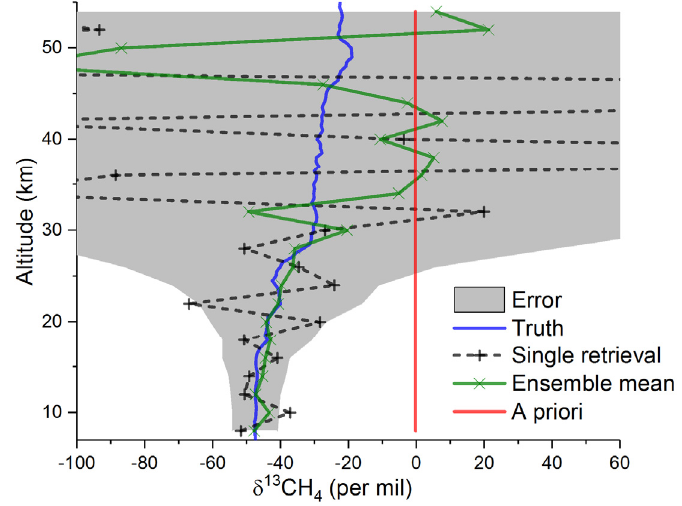
Figure 9. δ 13 CH 4 retrieval from the OSS in the case of ideal instruments. The black dashed profile is obtained from a single synthetic occultation. The green line represents 50 synthetic occultations averaged, assuming no atmospheric variability. The one-sigma error (grey area) is relevant to a single synthetic observation, centred about the truth.